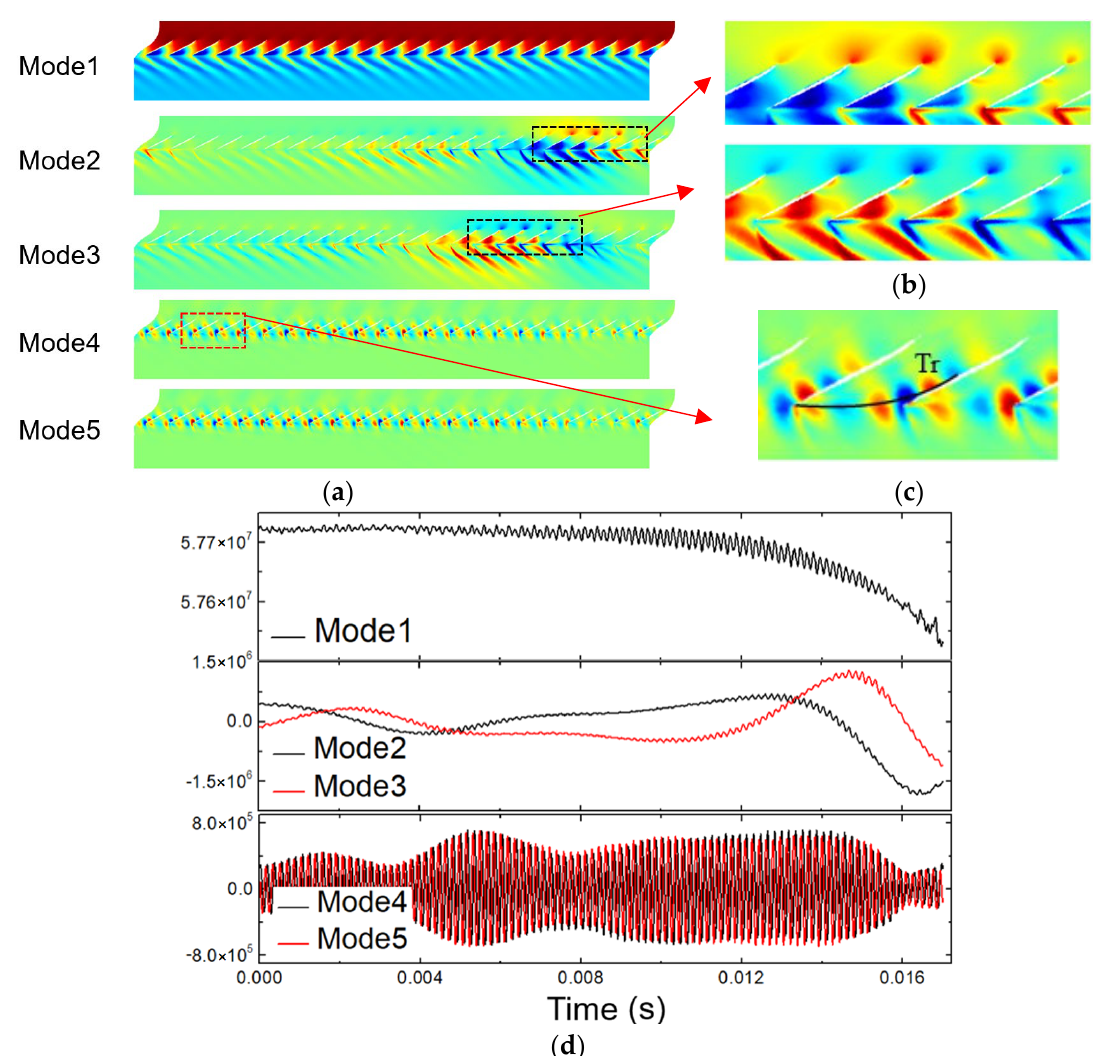
Figure 16. POD modes of the pre-stall stage. ( a ) POD modes. ( b ) Reverse flow vortex features. ( c ) TCV trace. ( d ) Mode coefficient.